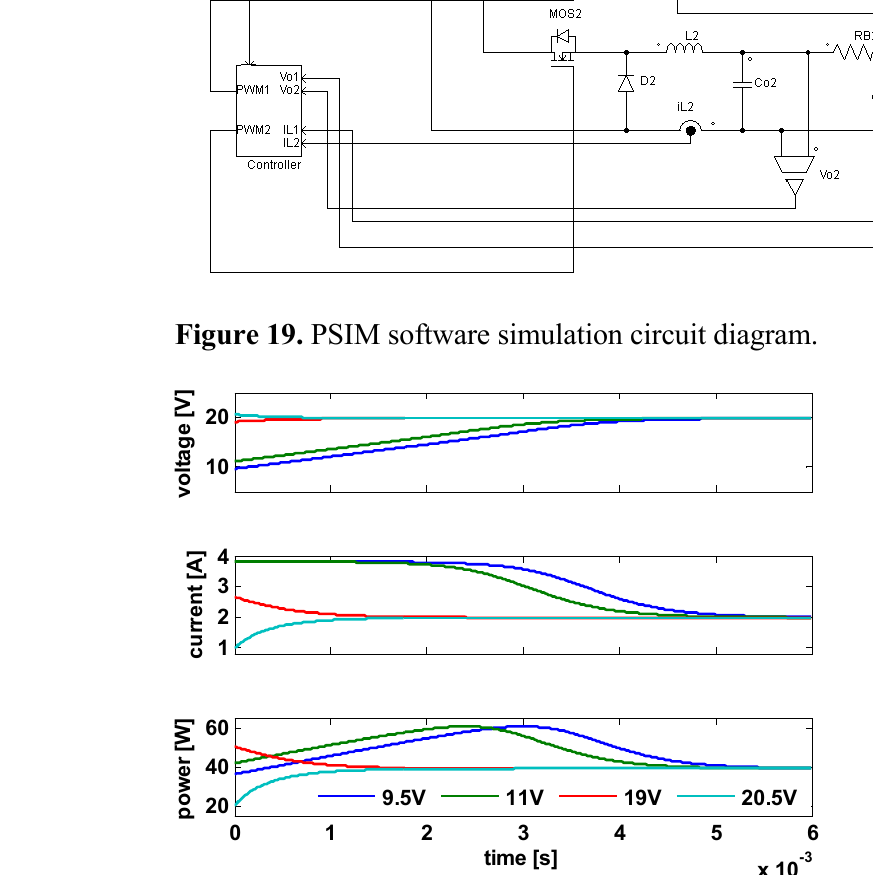
Figure 20. Voltage open-loop system behavior for different initial values of SA terminal